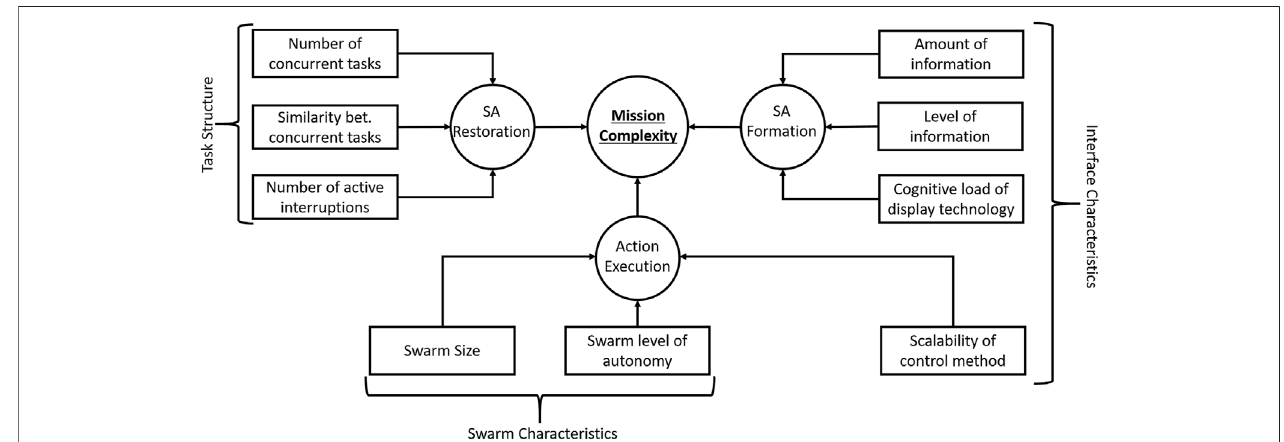
FIGURE 5 | Components of mission